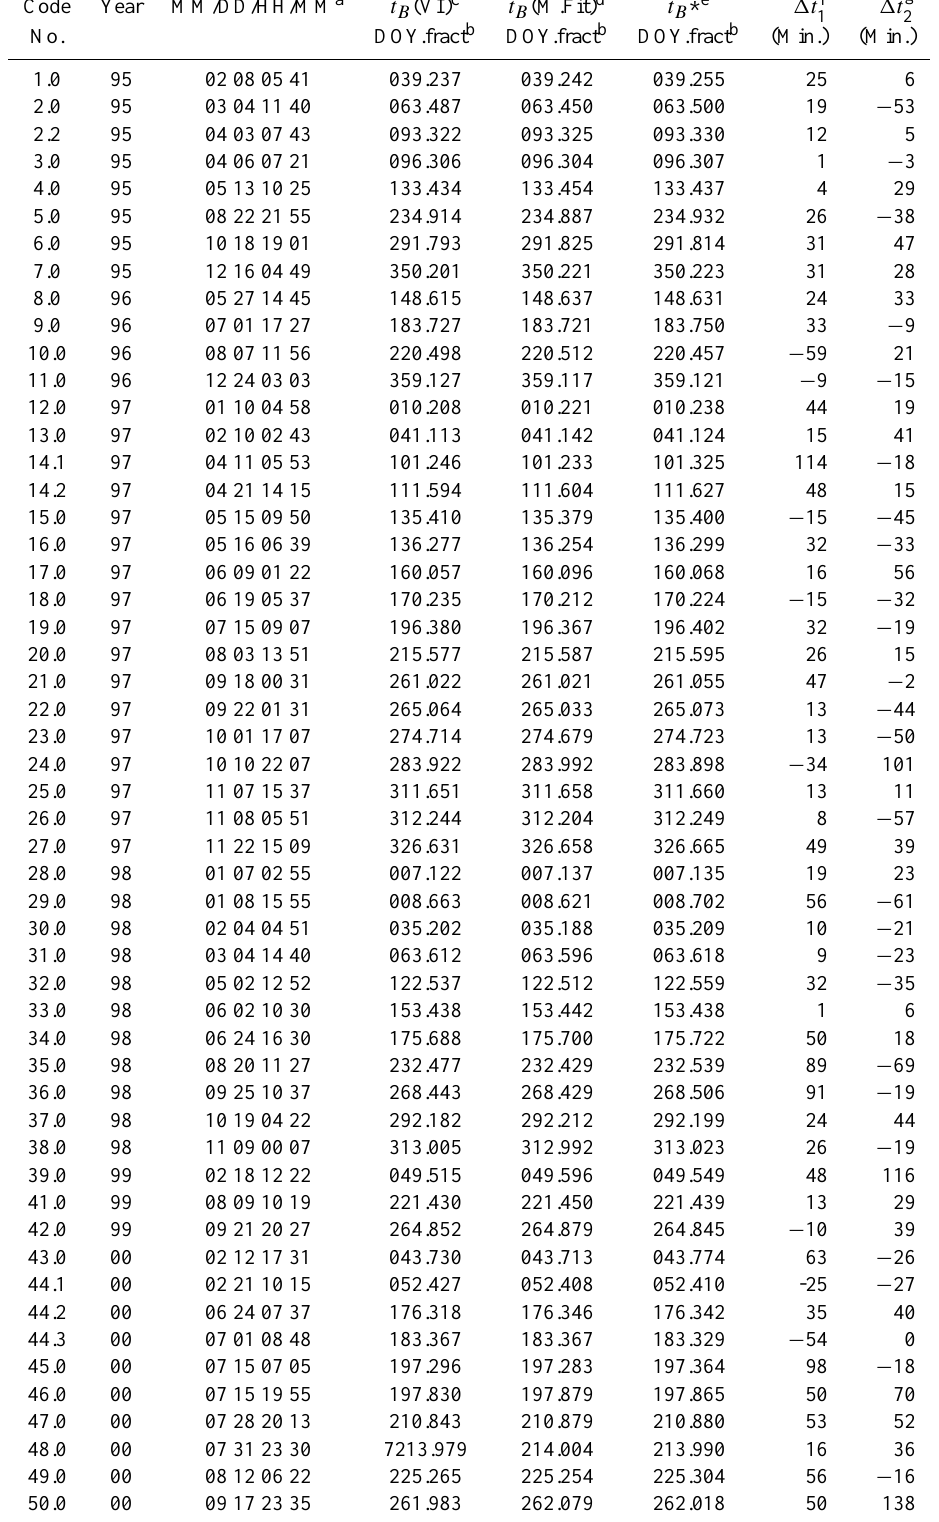
Table 1. MC Front Boundary Times ( t B (VI)) Chosen by Visual Inspection, by the Model Fitting routine, and by the Boundary Estimation Scheme ( t B *) for WIND N =81 WIND